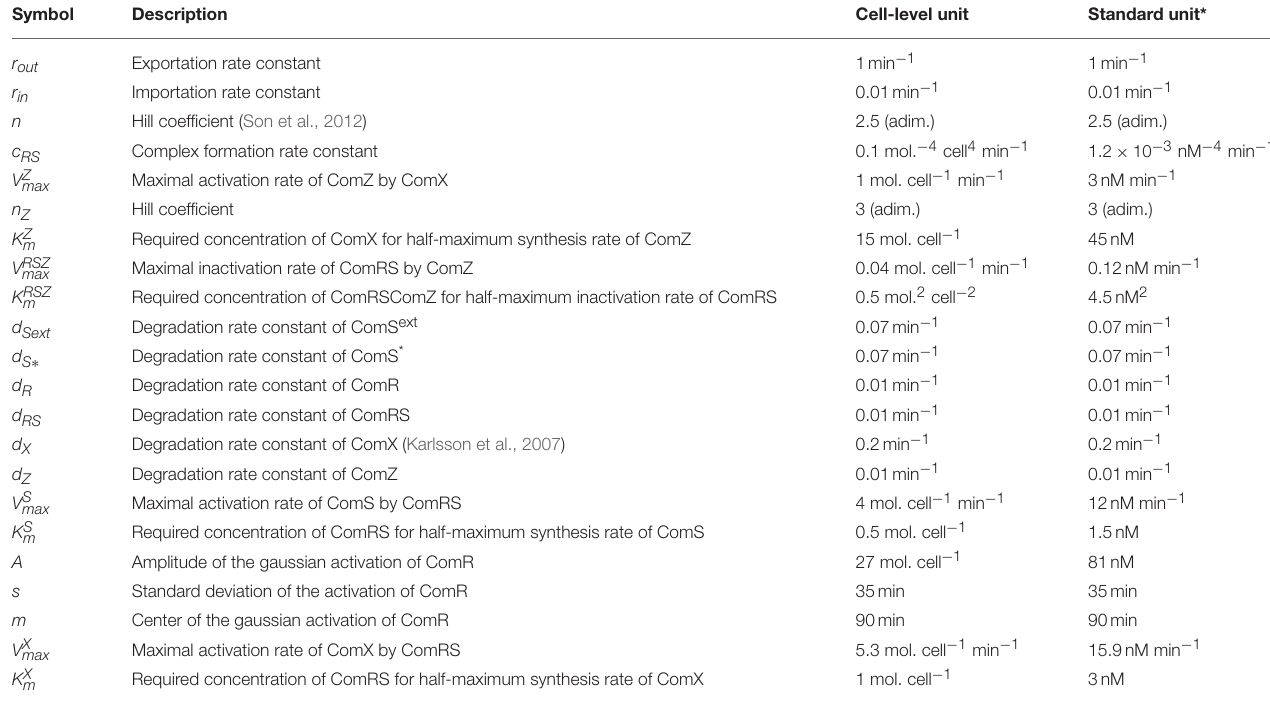
TABLE 2 | Description and numerical values of parameters in system S1.